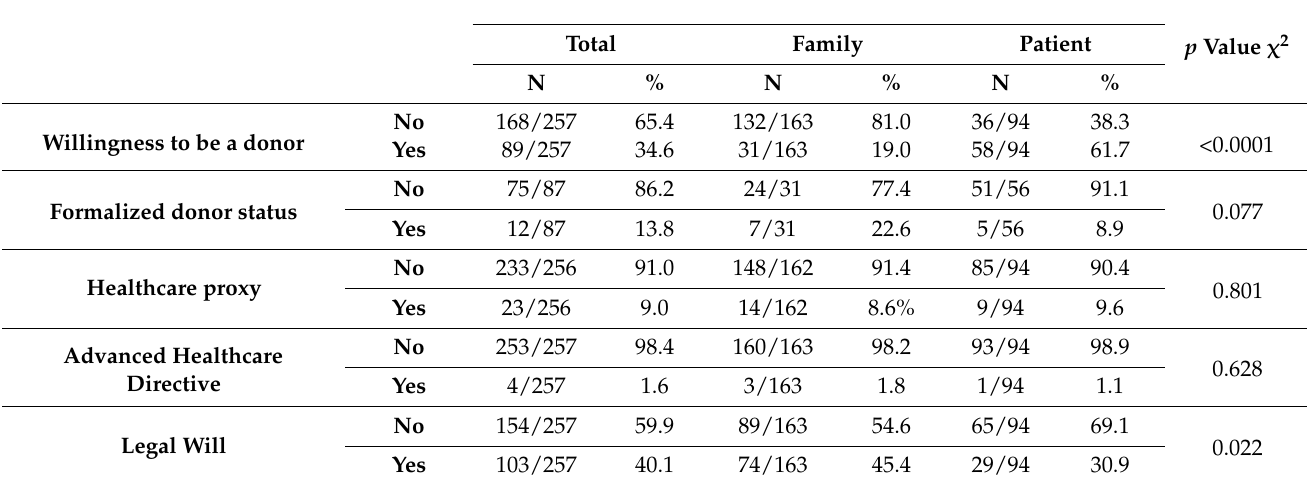
Table 4. Patients’ and relatives’ responses regarding organ donation, advance directives, healthcare proxy, and the possession of a legal